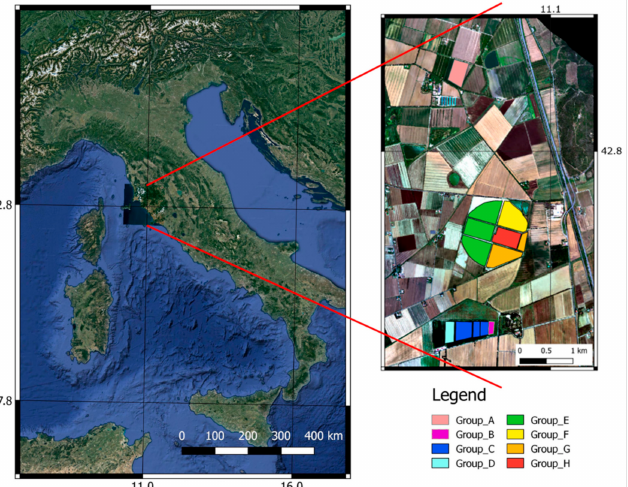
Figure 2. Study area: Le Rogaie, Grosseto, Tuscany (Italy). The base map used for the image on the left was downloaded from the Google catalogue made available for the QGIS plugin QuickMapService. The base map used for the image on the right is a true color composite based on HyPlant raw data recorded on 20 July 2018 during SurfSense 2018 [51].